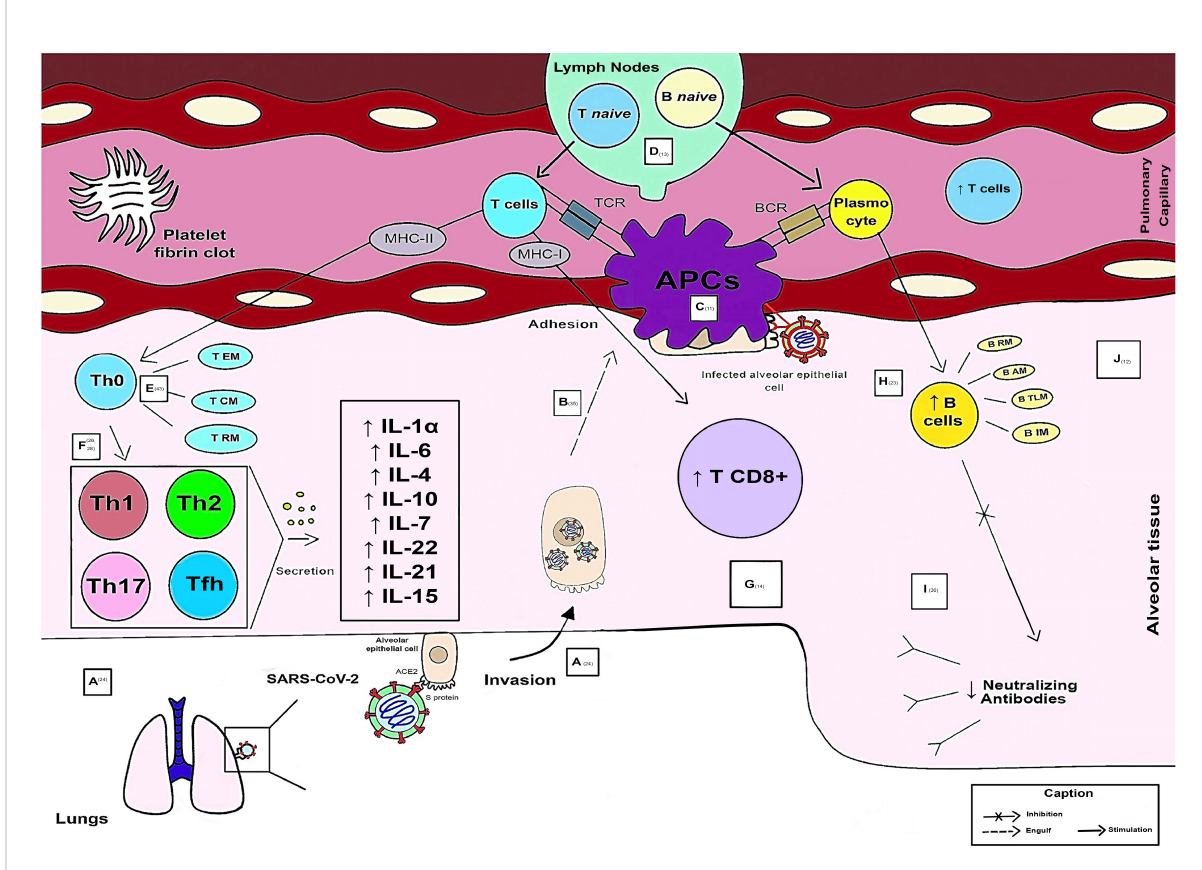
FIGURE 2 Schematic model of the evolution of the Adaptive Immune Response in mild and moderate cases of